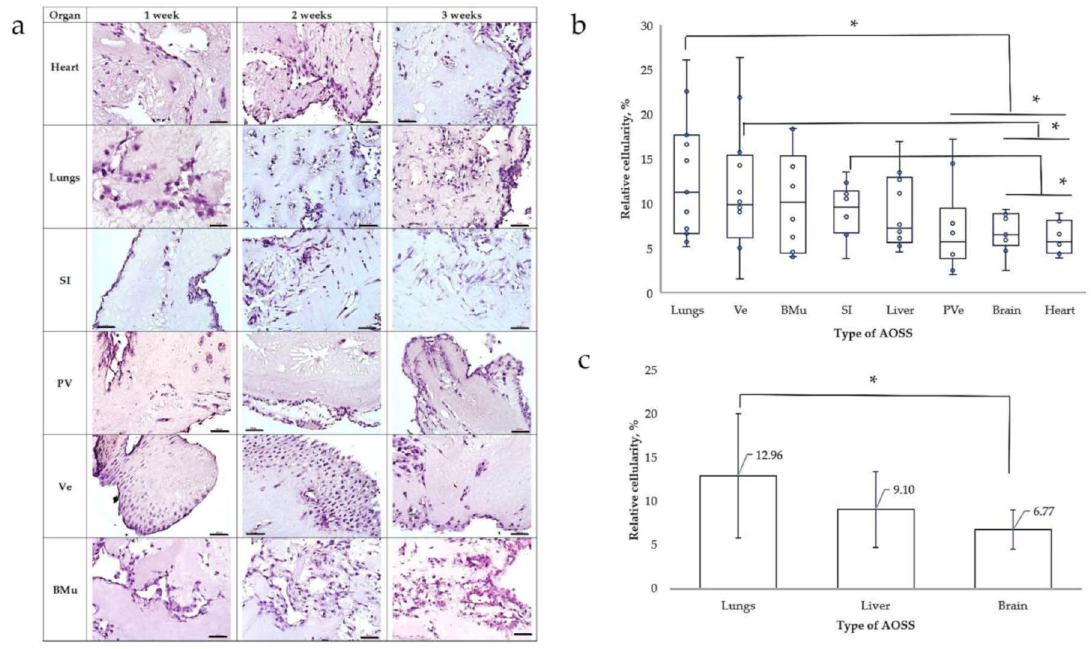
Figure 3. ( a ) Structural evolution of the organ-specific TECs that combine human MDA-MB-231 cells and CE AOSSs, as observed histologically during 3 weeks of in vitro culture. All of the TECs demonstrate initial colonization of the surface areas with cancer cells, followed by progressive invasion into the deeper parts of the scaffolds with increasing total cellularity. Note the organ-specific colonization patterns such as cells’ growth in association with the luminal ECM elements, such as the former walls of blood vessels in the heart and BMu, and colonization of parabronchial ECM in the lung TECs; linear pattern (“Indian-files”) of tumor invasion along the former muscular layers in SI ECM and the tunica muscularis in Ve; and the templated colonization of the former glandular elements and secretory lining of PV and Ve. Staining with Hematoxylin and Eosin. Scale bars, 50 µ m (brains, hearts, lungs, SI, and BMu) and 100 µ m (PV and Ve). ( b ) Relative cellularity of the TECs combining MDA-MB-231 cells and AOSS obtained from the different organs of origin on the 7th day of in vitro culture. Blue circles indicate the individual values, the blue horizontal lines show the mean, the boxes represent the range between the 25th and 75th percentiles, and the whiskers reflect the minimal and maximal observed values. Statistically significant differences (* p < 0.05) between the studied TECs are shown by black lines. ( c ) Relative cellularity (mean ± standard deviation) of the MDA-MB-231/AOSS TECs representing the common cites of the distant organ metastases of breast cancer. Statistically significant difference (* p < 0.05) between the lung and brain TECs is shown by a black line. Abbreviations: SI—small intestine; PV—proventriculus; Ve—ventriculus; BMu—breast